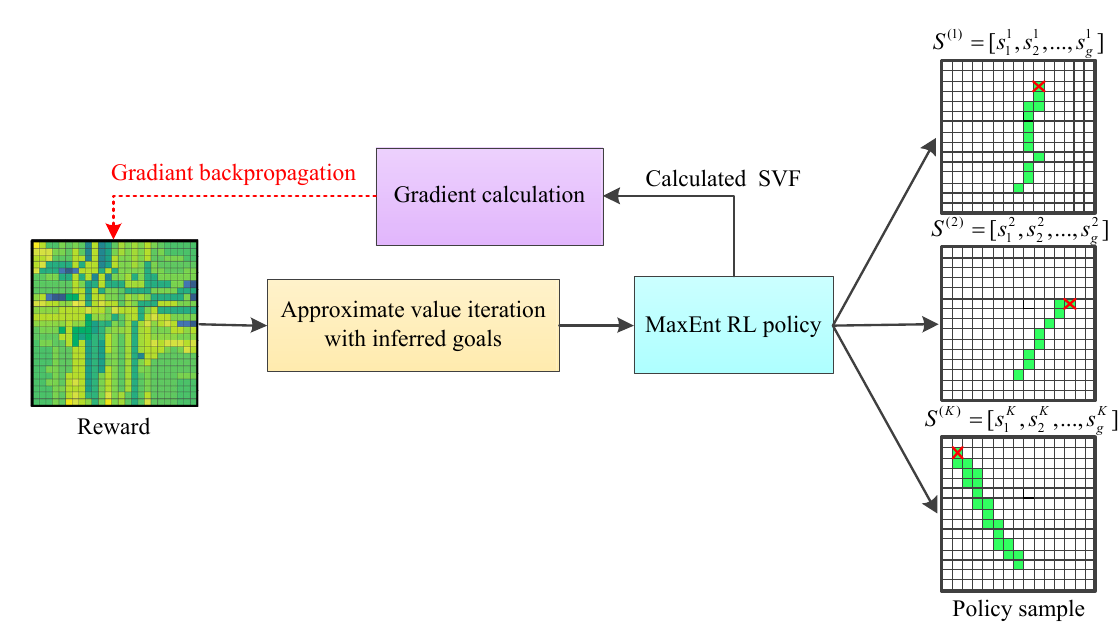
Figure 3. Reward updating based on MaxEnt RL policy. The MaxEnt RL policy consists of two main algorithms [32]. One algorithm is the approximate value iteration, which solves the current reward function and targets the state received from the upper MaxEnt RL policy. The other algorithm is policy propaga ‐ tion, which involves repeatedly calculating the state visitation frequencies (SVF) at each step of the policy generation process. For the convergent reward model r, it can be sam ‐ pled from it to give predictions from the initial state to the target path on the 2D grid. Since the policy is stochastic, there are multiple trajectories to reach the goal state. i s , which are sampled from the MaxEnt RL policy and Given the state sequences